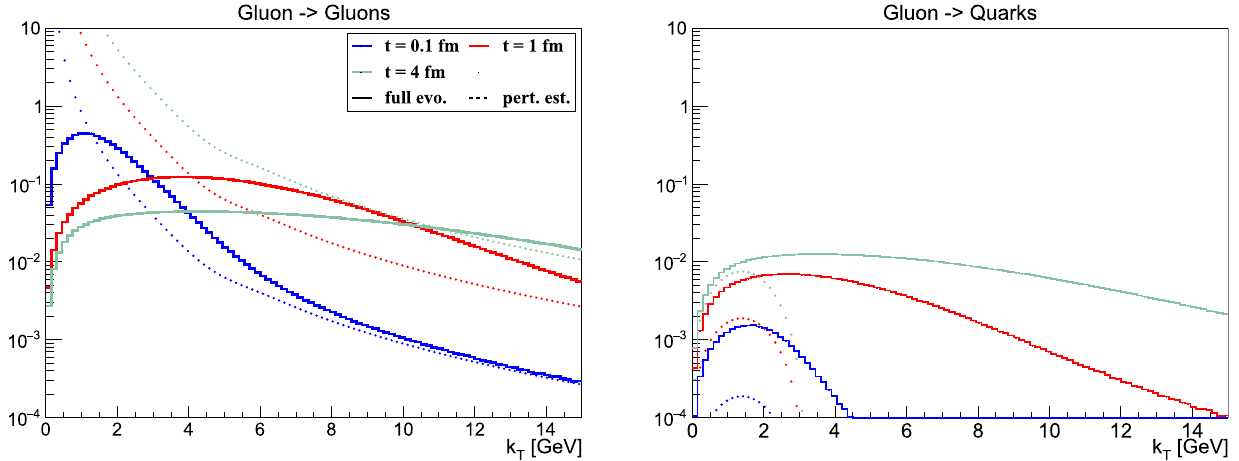
Fig. 13 The ˜ D ( k T , t ) distributions at the time-scales t = 0 . 1 , 1 , 4fm: cascades initiated by gluon. The solid lines correspond to the full medium evolution and the dotted line to the perturbative